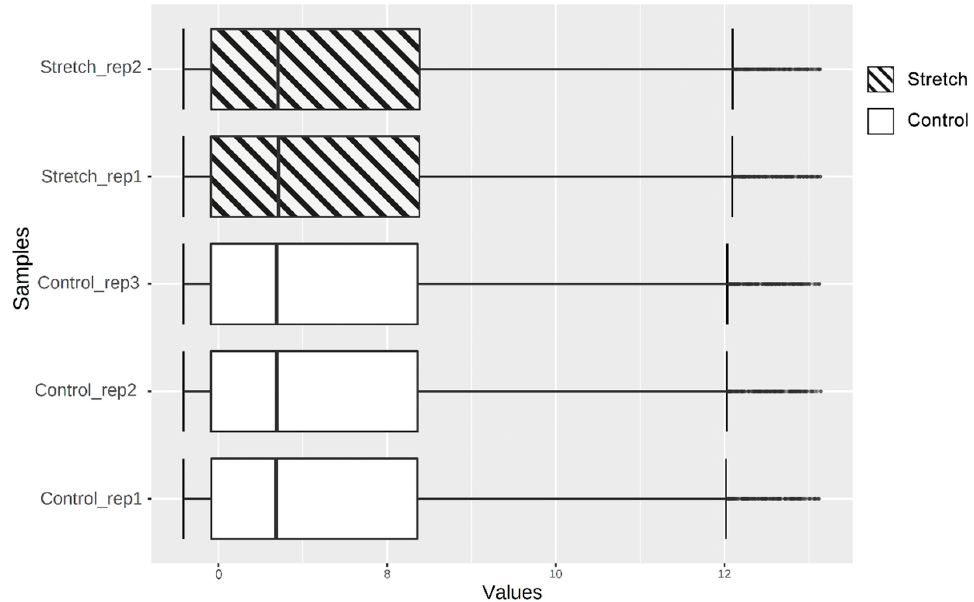
Figure 1. Boxplot of quantile normalised data. Vertical black lines in the boxes represent medians.